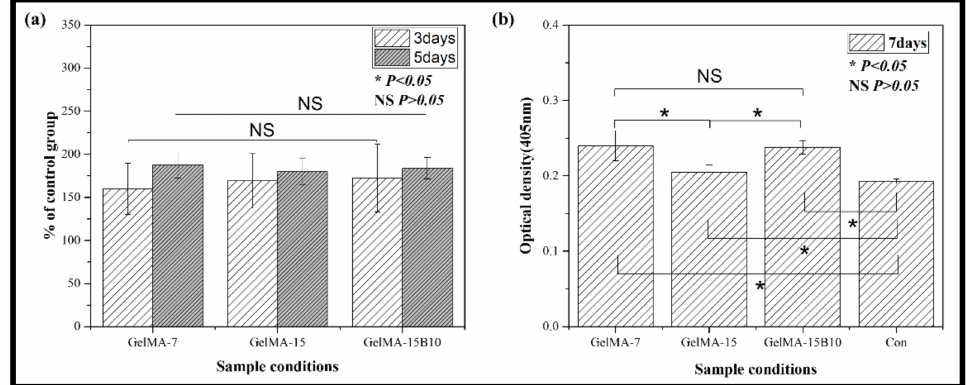
Figure 7. Proliferation (by water-soluble tetrazolium salt (WST)) and differentiation assessment (by alkaline phosphatase (ALP)) of MC3T3-E1 cells on the GelMA-7, GelMA-15, GelMA-15B10, and Control(con) groups after ( a ) three and five days of culture for WST assay and ( b ) seven days of culture for ALP